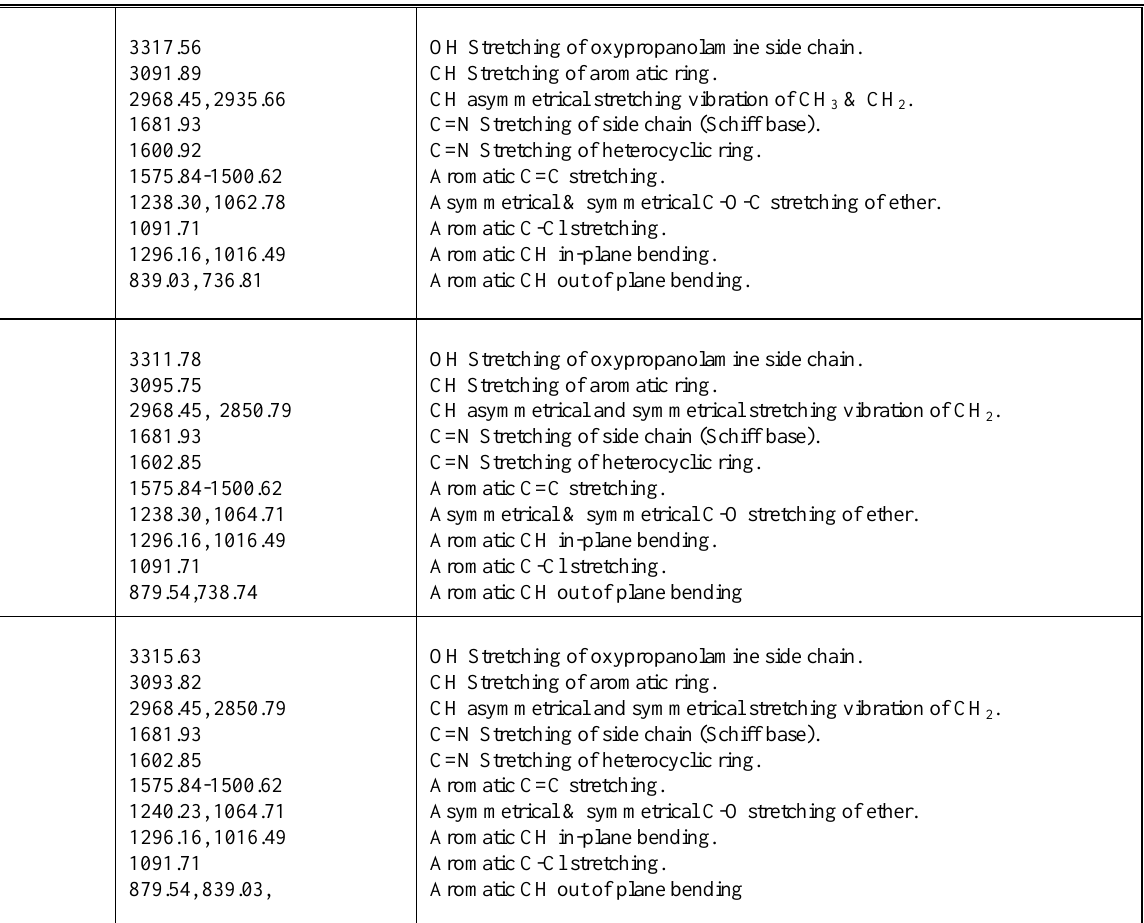
Table (4): Characteristic IR absorption of the final